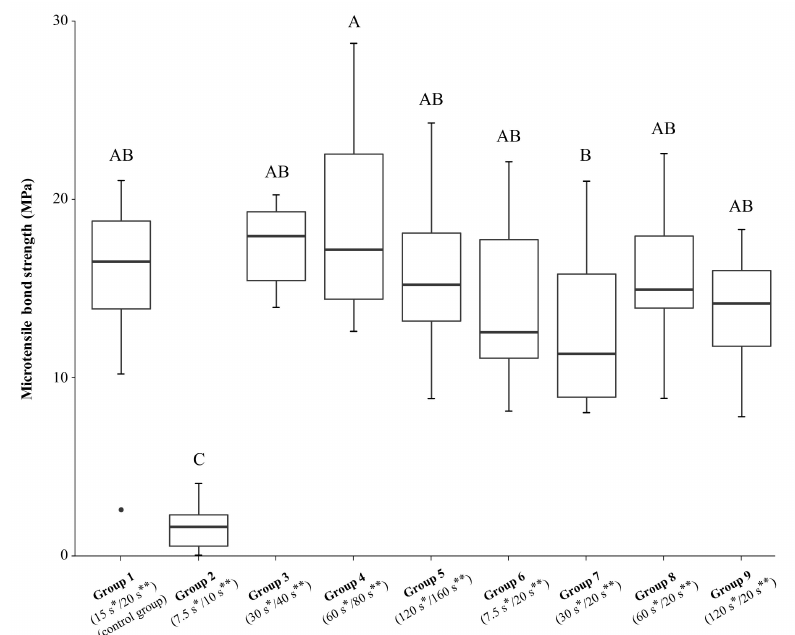
Figure 2. Microtensile bond strength (MPa) of dentin–composite interfaces after di ff erent phosphoric etching and adhesive application times. Groups marked with di ff erent letters are significantly di ff erent from each other at the 0.05 level. The boxplots show the medians (black lines) with 25% and 75% quartiles (boxes); the whiskers represent 1.5 × interquartile range (IQR), or minima and maxima of the distribution if below 1.5 × IQR. The outlier in group 1 is depicted as dot. * Phosphoric acid etching time; ** adhesive application time.